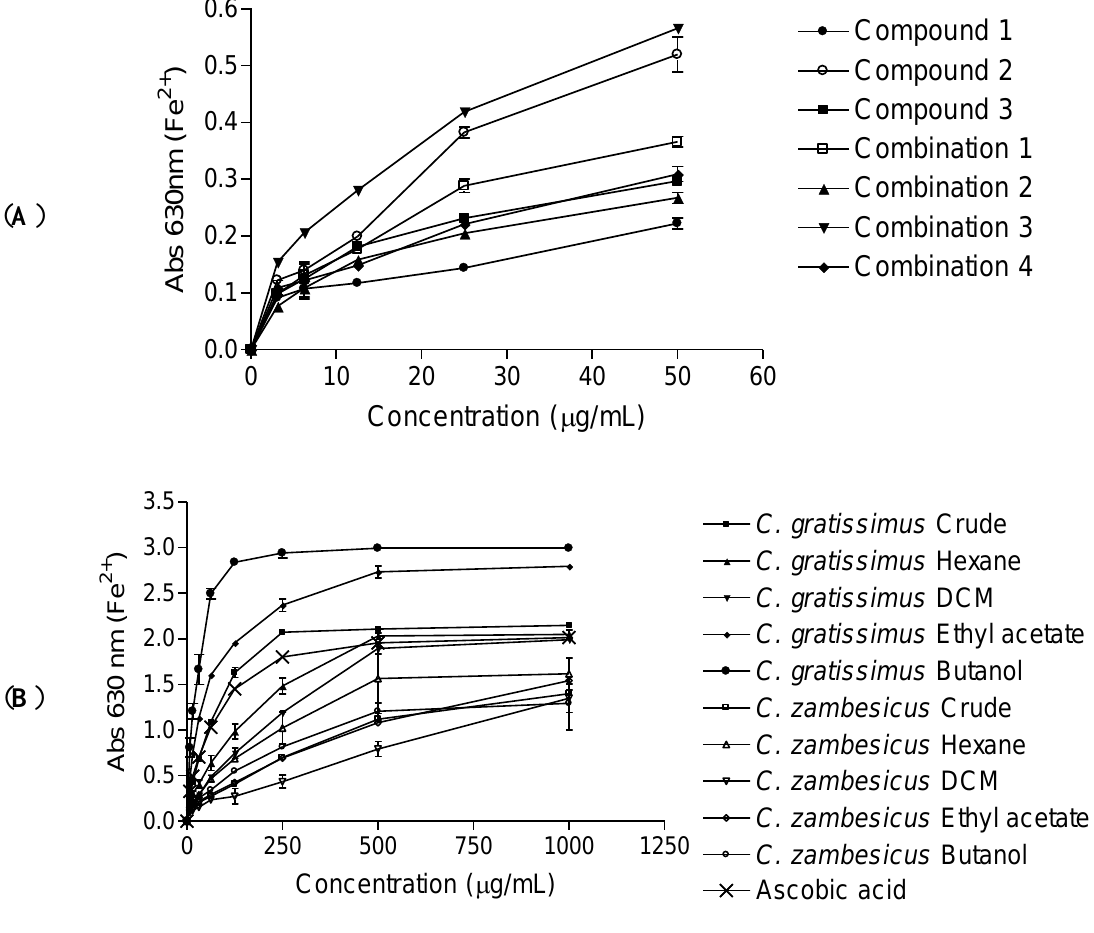
C. gratissimus and C. zambesicus . ( A ); Helichrysoside-3'-methyl ether ( 1 ), tiliroside ( 2